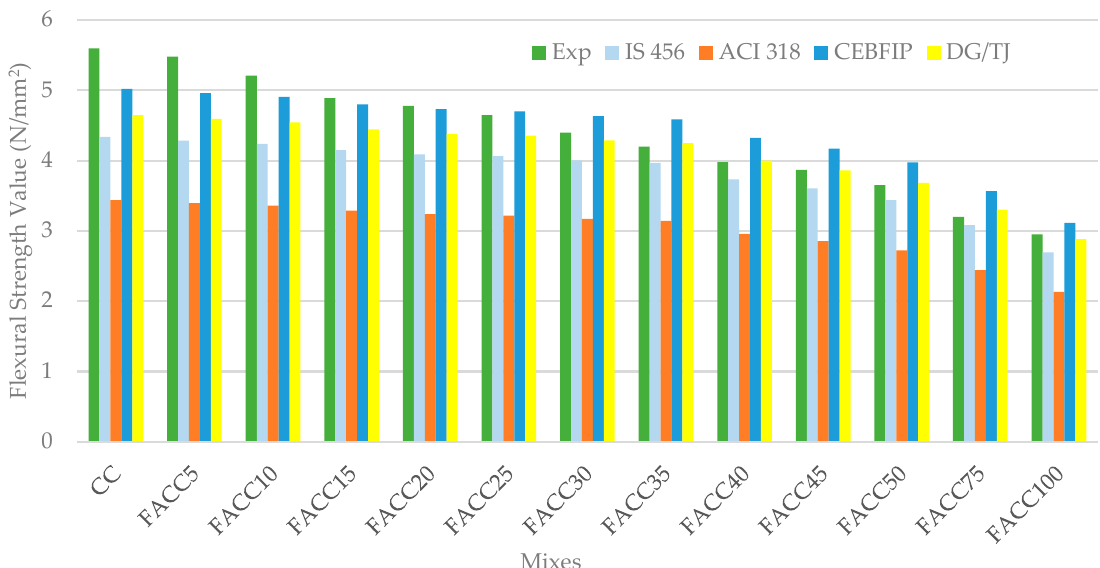
Figure 9. Comparison of Experimental Value to Predicted Flexural Tensile Values.